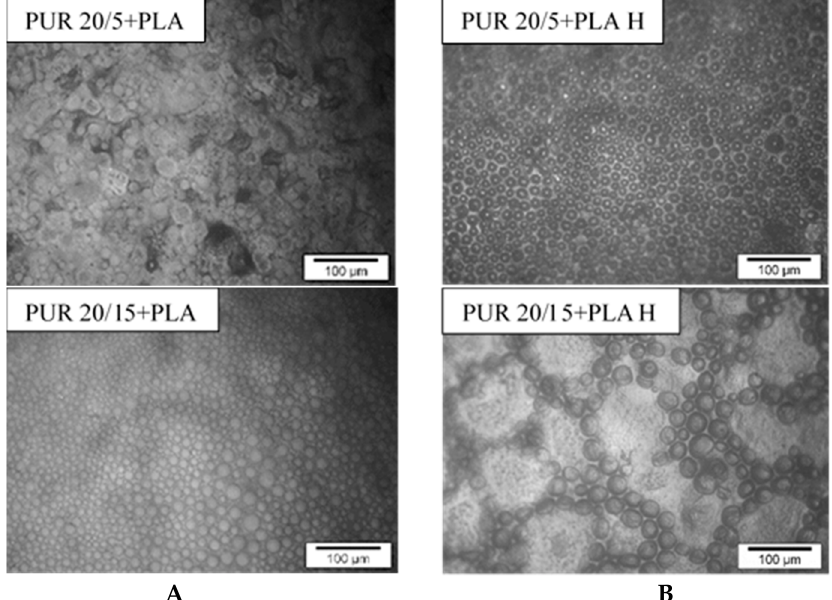
A B Figure 7. Microscopic images of the surface of PUR 20/5+PLA and PUR 20/15+PLA samples before ( A ) and after 12 weeks ( B ) of incubation in phosphate buffer.